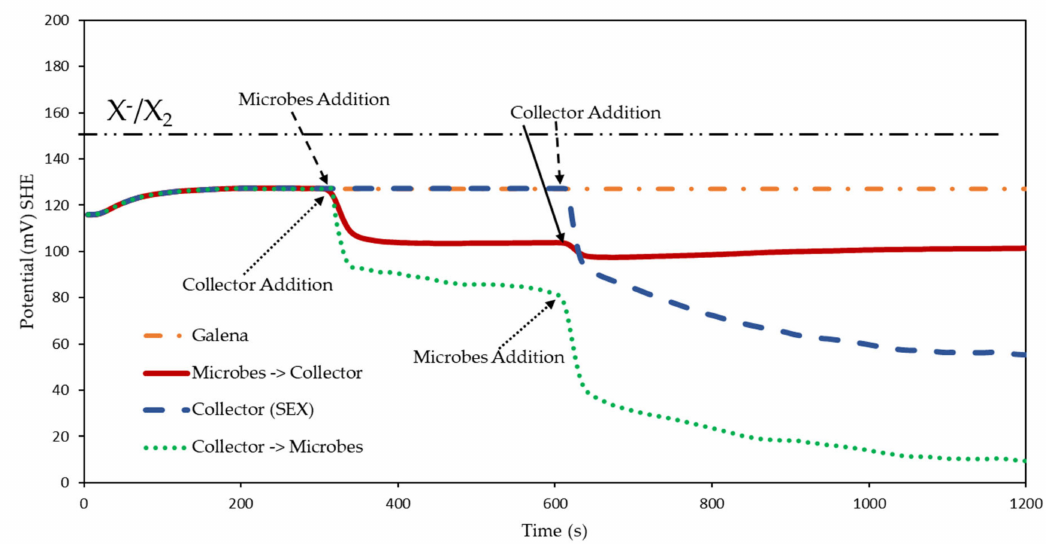
Figure 4. Mixed potential of galena in the presence of 2.4 × 10 − 4 mol / L SEX, 1 × 10 8 cells / mL microbes, 0.1 M Na 2 SO 4 and 0.05 M Na 2 B 4 O 7 (pH 9.3) at 25 ◦